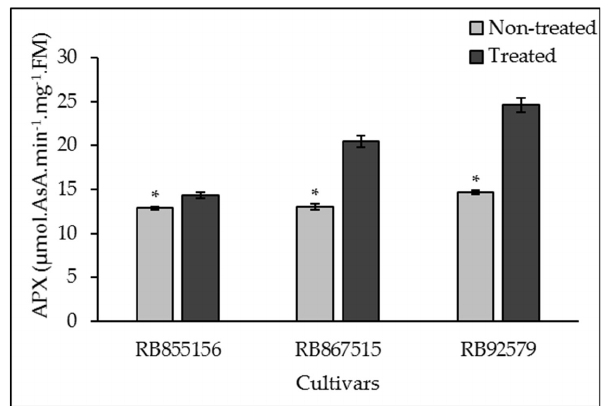
Figure 5. Activity of the ascorbate peroxidase (APX) enzyme in sugarcane plants treated with pyraclostrobin in relation to control plants. The results represent the average of six evaluation times and three replications. * Indicates a significant difference among treatments by the Tukey test at 5% probability. The bar indicates the standard error of the mean. FM: Fresh matter.